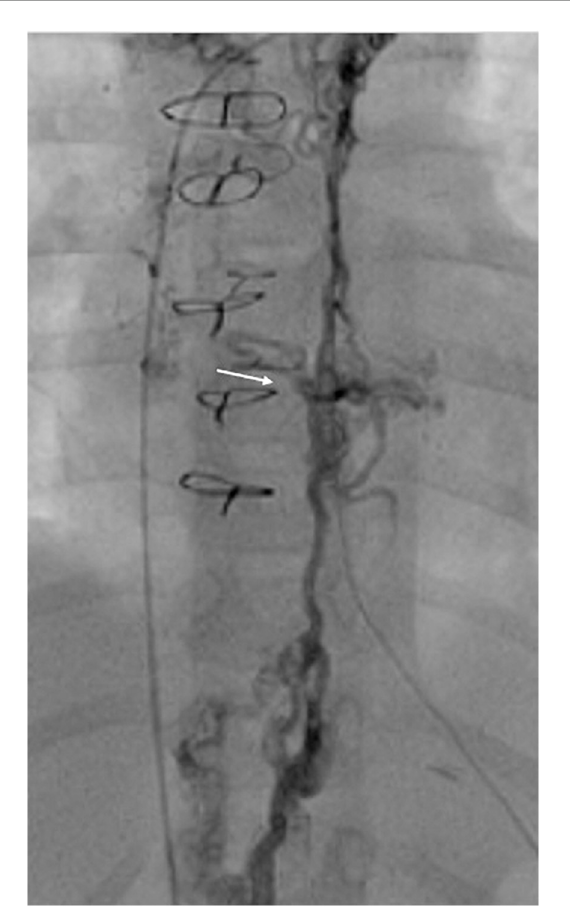
FIGURE7 Thoracic duct lymphography in a Fontan patient with plastic bronchitis: note the dilated thoracic duct with multiple and bilateral leaks toward the lungs (white